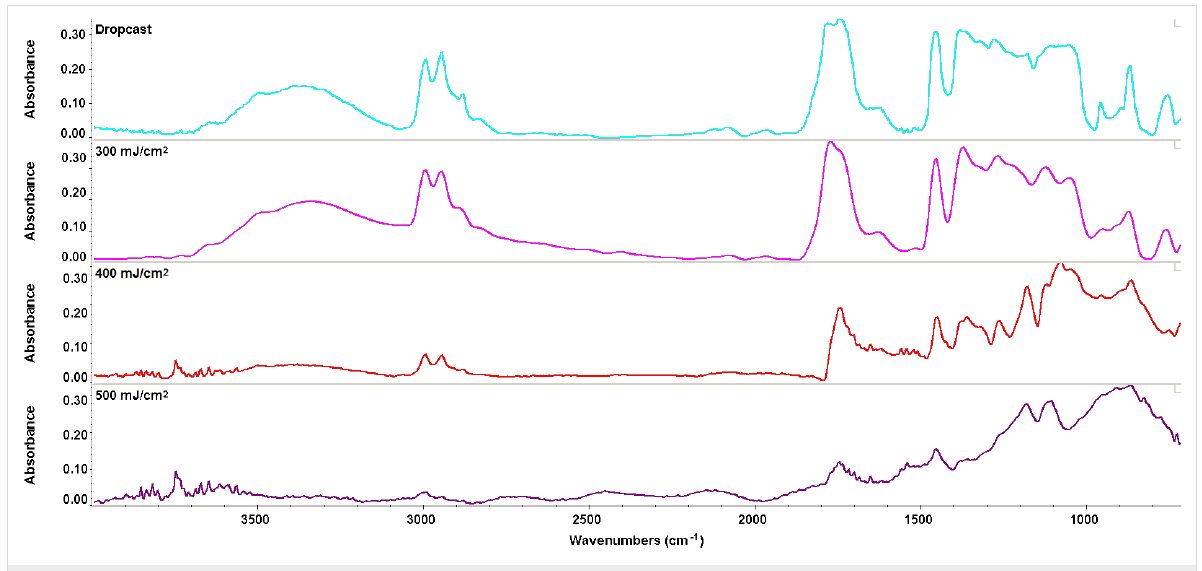
Figure 4: FTIR spectra of the drop cast surface and the thin coating surfaces ( F = 300/400/500 mJ/cm 2 ).